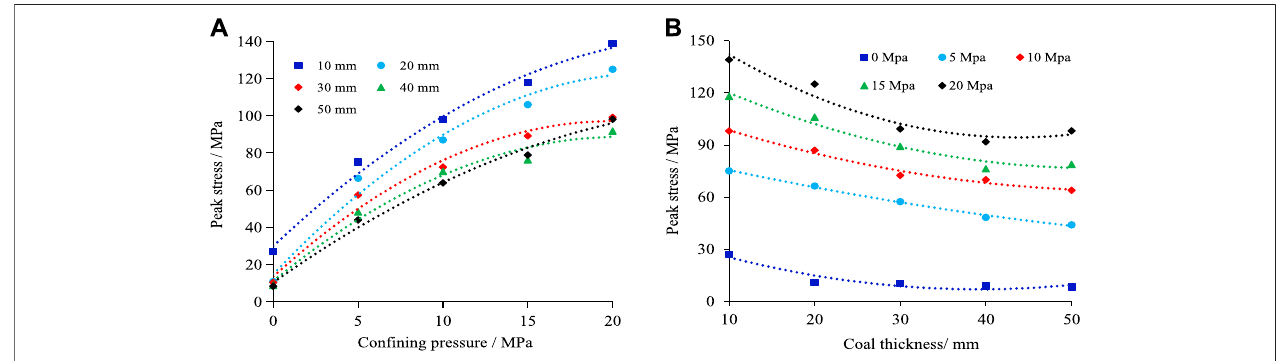
FIGURE 6 | Peak Stress of the RCR composites at different inclined coal seam thicknesses and different con fi ning pressures. (A) In fl uence of different con fi ning pressure; (B) In fl uence of different coal thickness.